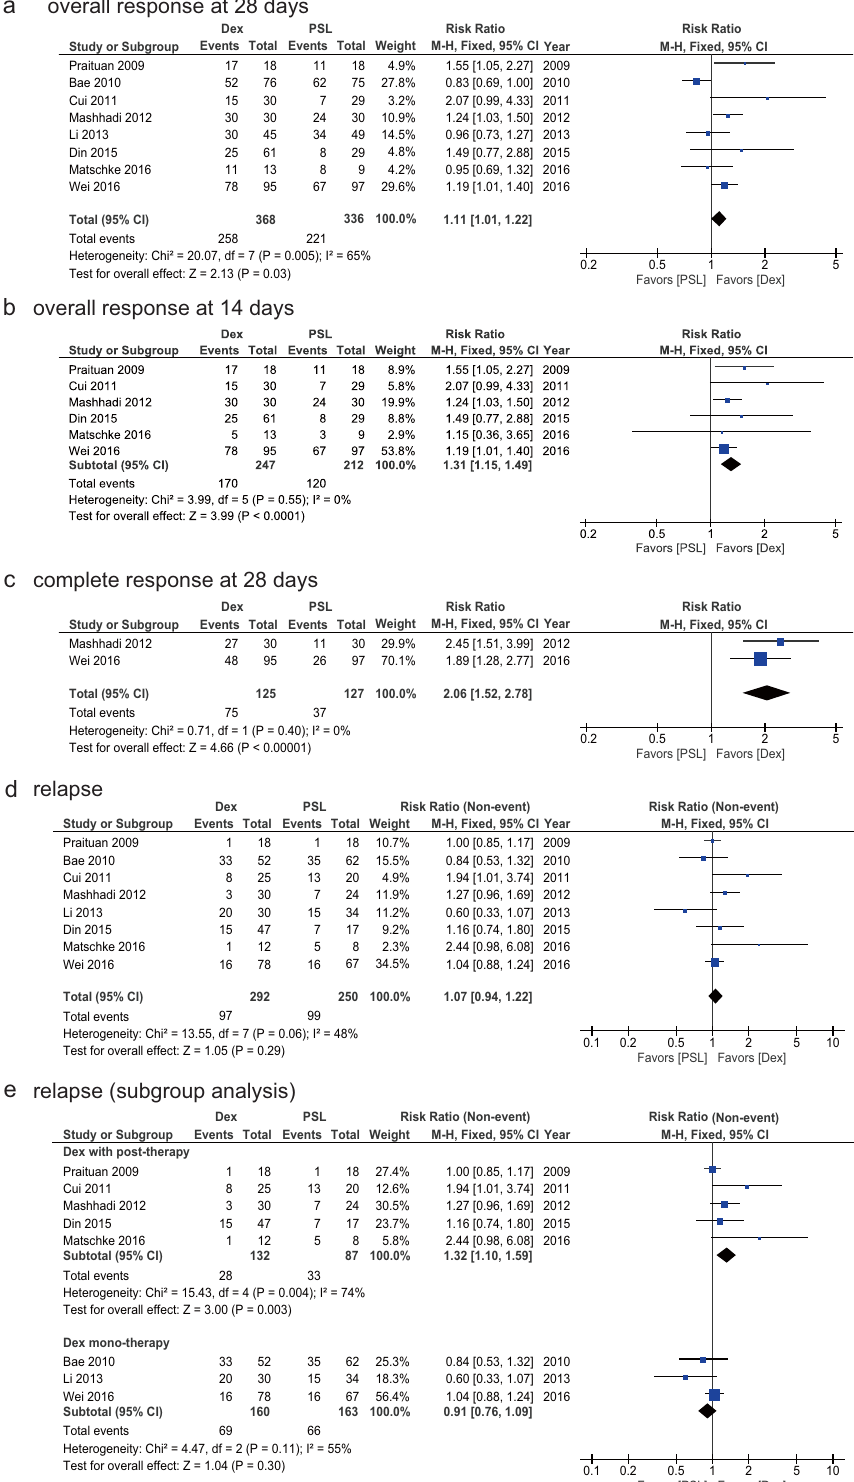
TH Open Vol. 1 No.